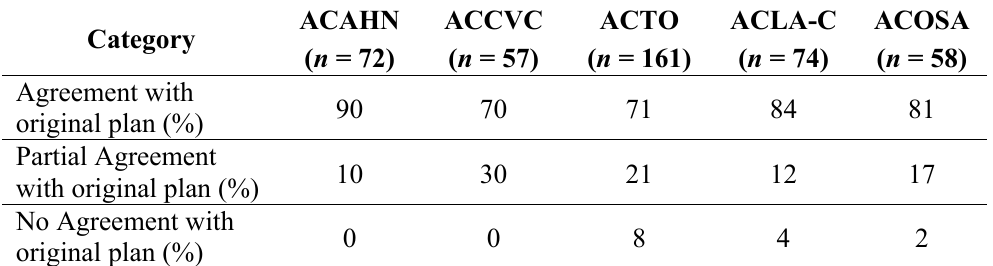
Table 2. Assessment of forest permanence after selective logging in five Conservation Areas in Costa Rica; the category agreement with original plan corresponds to a management plan that kept its original forest cover (aerial view analysis) after selective logging;